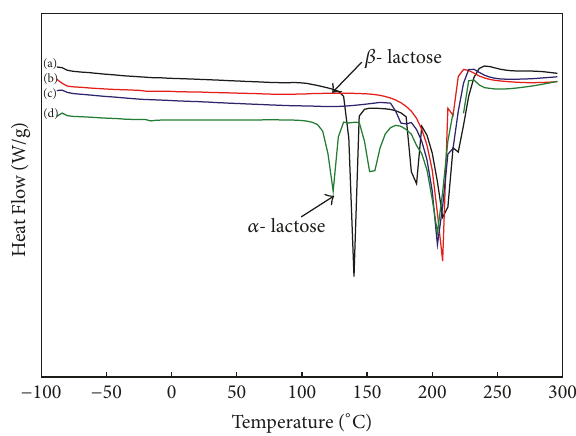
Figure 6: MDSC thermograms of the samples prepared at 27, 29, 31, and 32 ∘